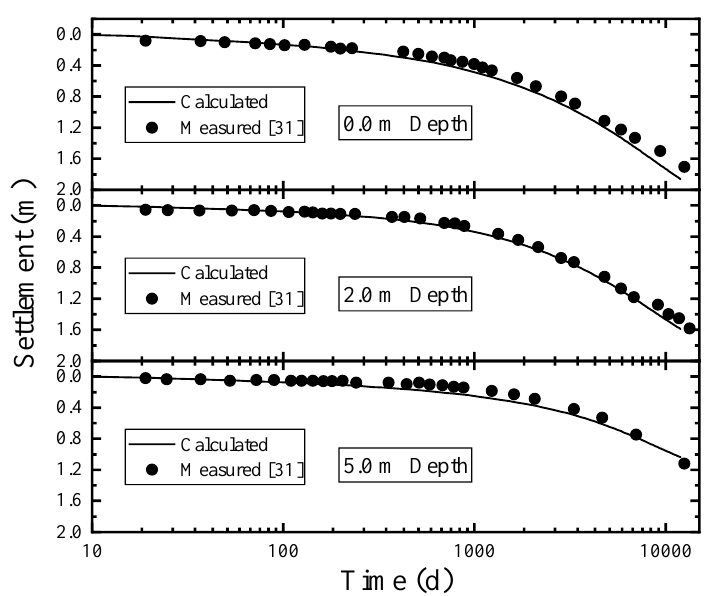
Figure 6. Comparisons of calculated and measured settlement along time.